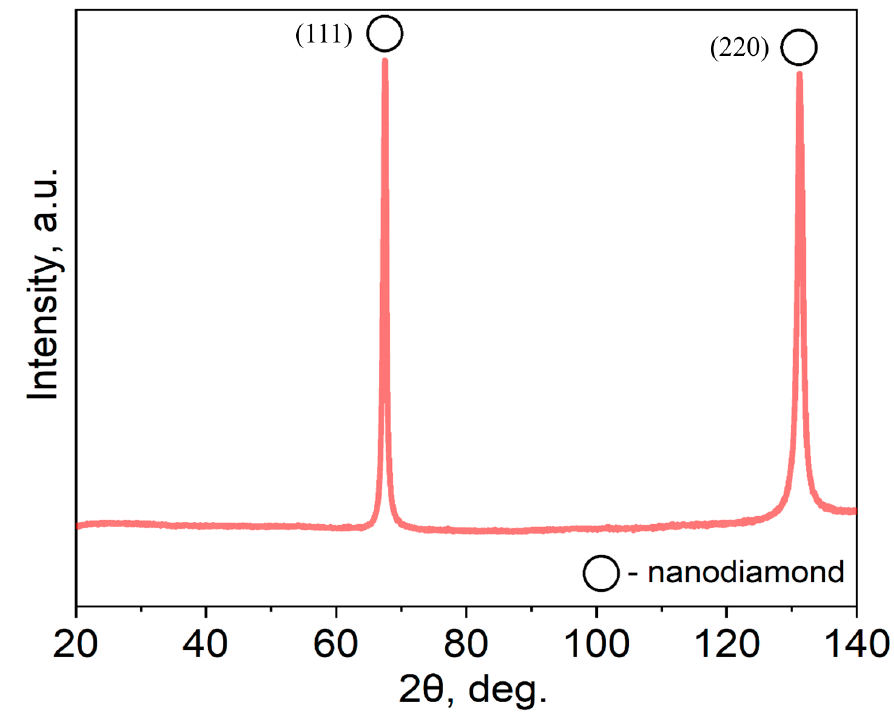
Figure 3. XRD pattern of initial nanodiamond particles.